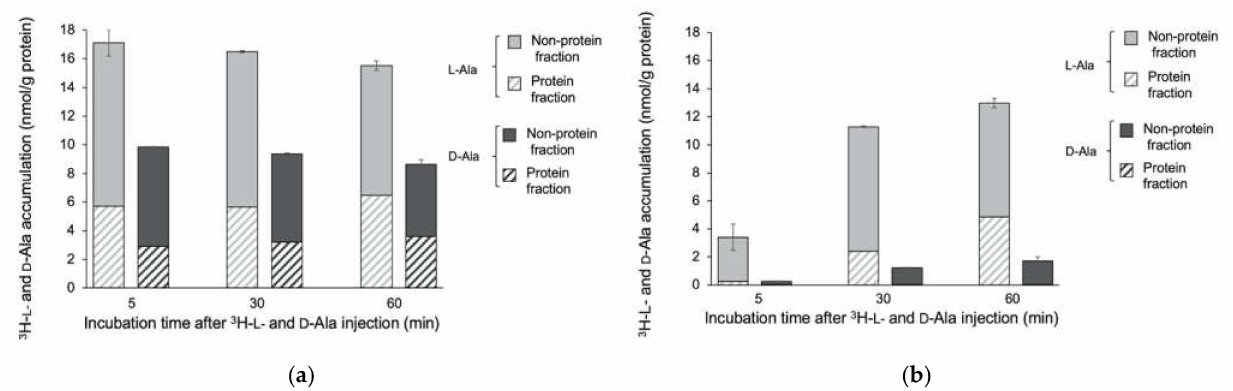
Figure 4. Accumulation of 3 H-L-Ala and 3 H-D-Ala in ( a ) E. coli EC-14 at 4 h after incubation and ( b ) accumulation of 3 H-L-Ala and 3 H-D-Ala in HaCaT cells at 5, 30, and 60 min after 3 H-L-Met and 3 H-D-Met injection. The accumulation of 3 H-L-Ala and 3 H-D-Ala in EC-14 at 5 min or later after incubation was higher than that in HaCaT cells. Similar incorporation rates of 3 H-L-Ala and 3 H-D-Ala were identified in accumulation into EC-14.